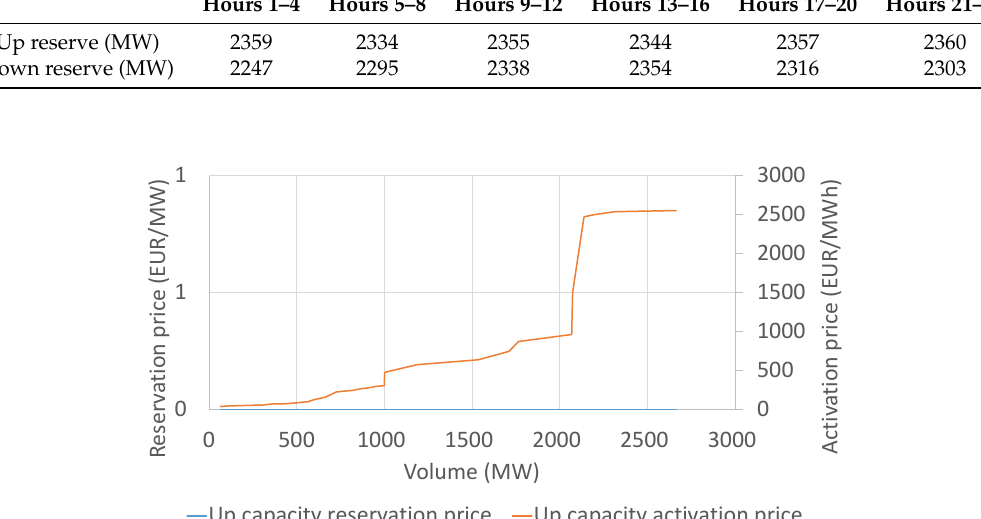
↑ ) and down ( R cap t